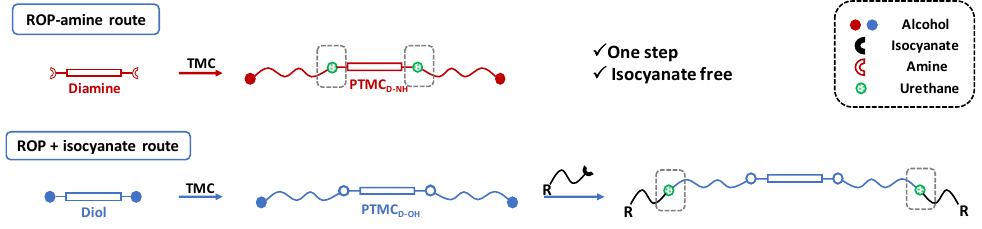
Figure 1. Comparative routes toward poly(trimethylene carbonate) (PTMC)-urethane by ring-opening polymerization (ROP)-amine route and polyaddition of isocyanate in PTMC terminal diols.